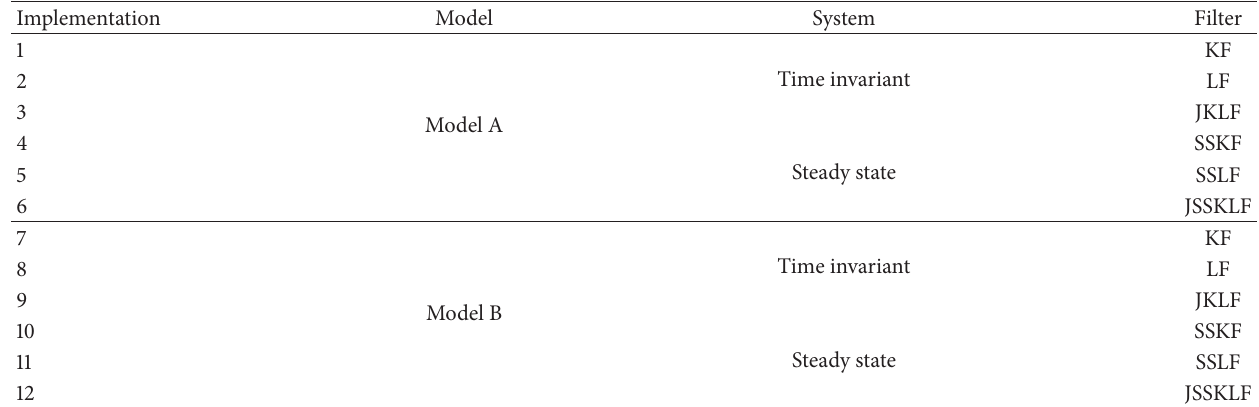
Table 1: GSM position tracking